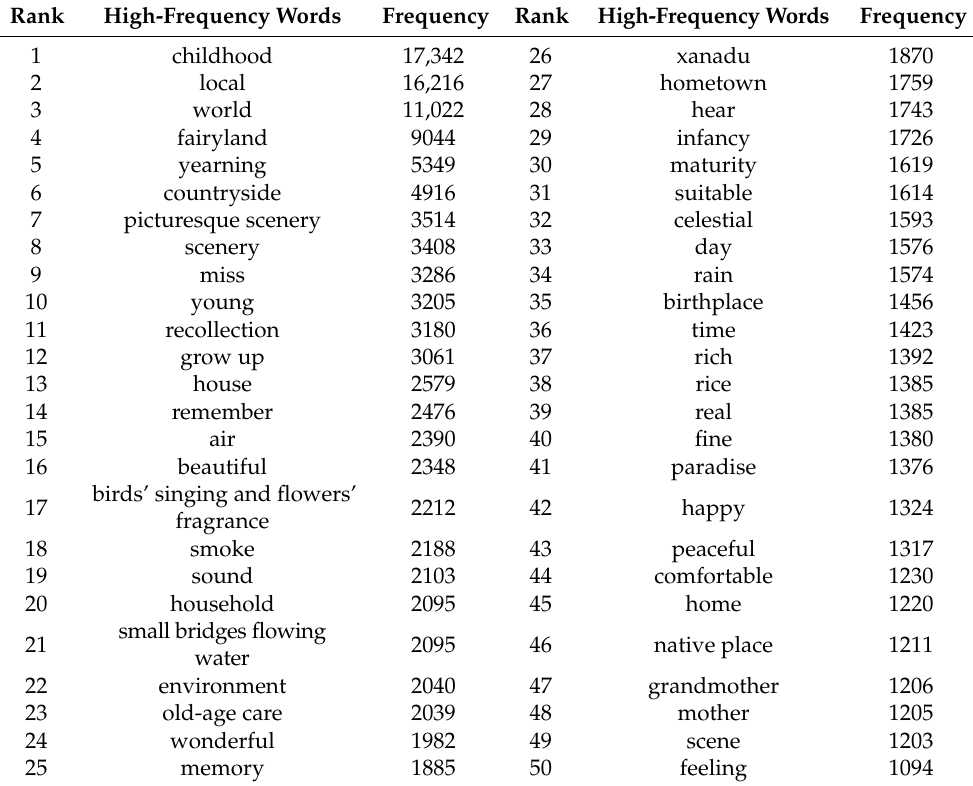
Table 3. High-frequency characteristic words for rural landscape evaluation,